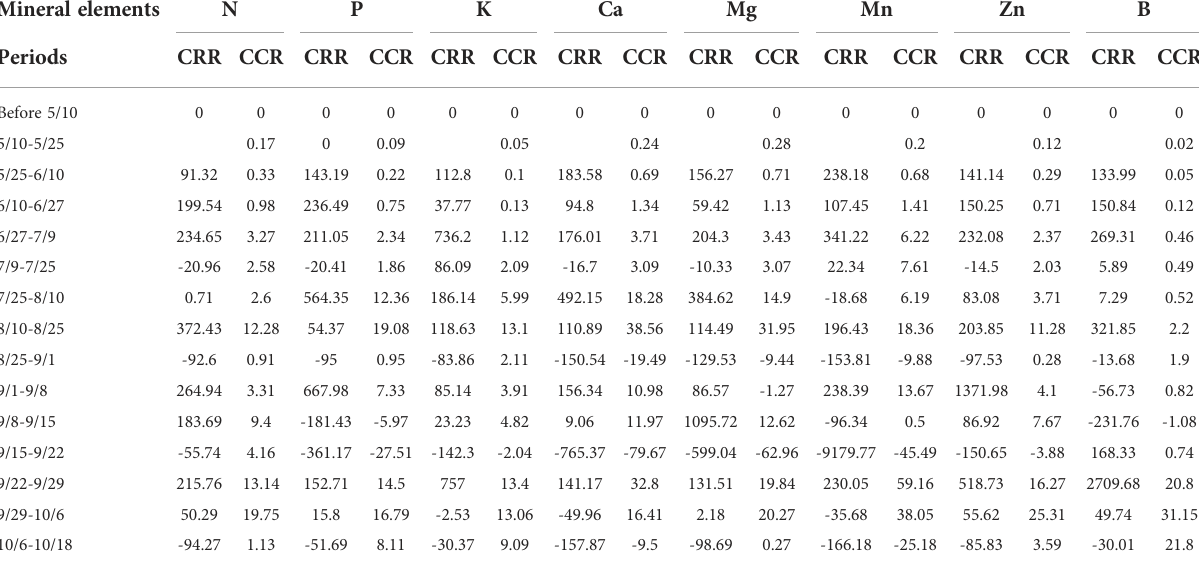
TABLE 2 Cumulative relative rate and cumulative contribution rate of 8 mineral elements over time. Mineral elements